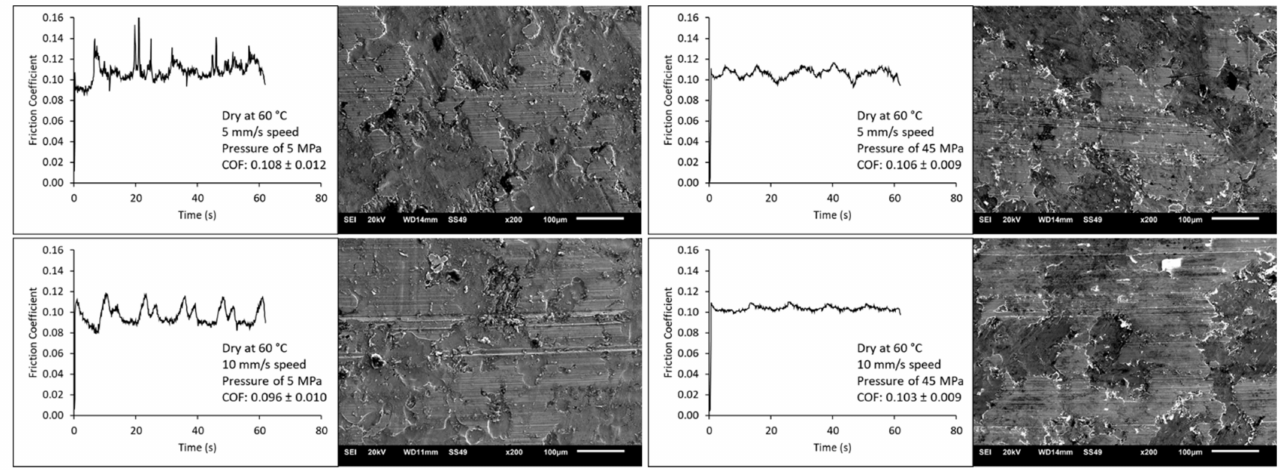
Figure 10. Measurement of coefficient of friction (COF) together with SEM analysis, for tests without lubricant, at 60 ◦